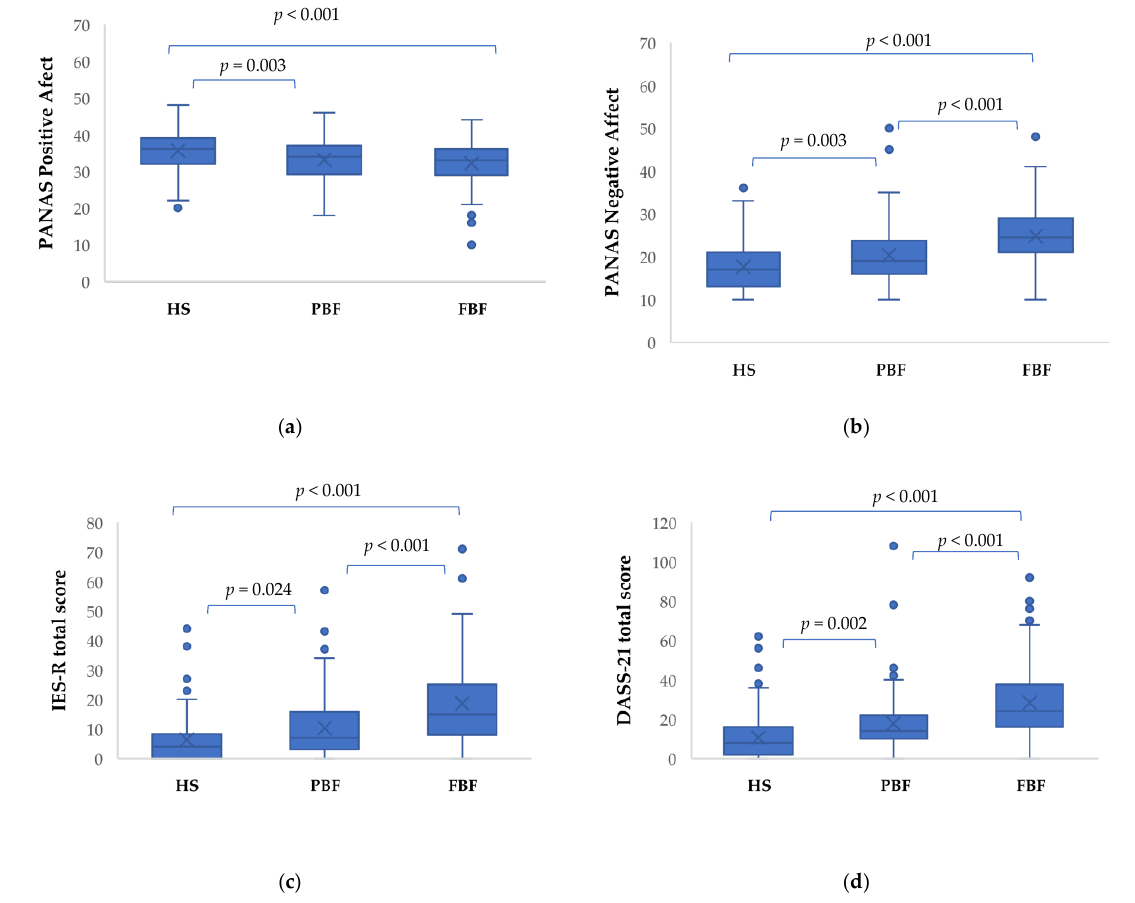
Figure 1. Boxplots and p -values of ANCOVA tests comparing HS, PBF and FBF on neuropsychiatric characteristics. PBF and FBF showed higher levels of Negative Affect ( b ), post-traumatic symptoms ( c ) and psychopathological symptoms (Fig.1d). HS showed higher levels than PBF and FBF only for Positive Affect ( a ). FBF showed higher levels than PBF of Negative Affect ( b ), post-traumatic and psychopathological symptoms ( c , d ). HS = Healthy Subjects; PBF: Probable Brain Fog FBF: Functional Brain Fog; IES-R = Impact of Event Scale-Revised; DASS-21 = Depression Anxiety Stress Scales-21; PANAS = Positive Affect and Negative Affect Schedules; PA = Positive Affect; NA = Negative Affect.